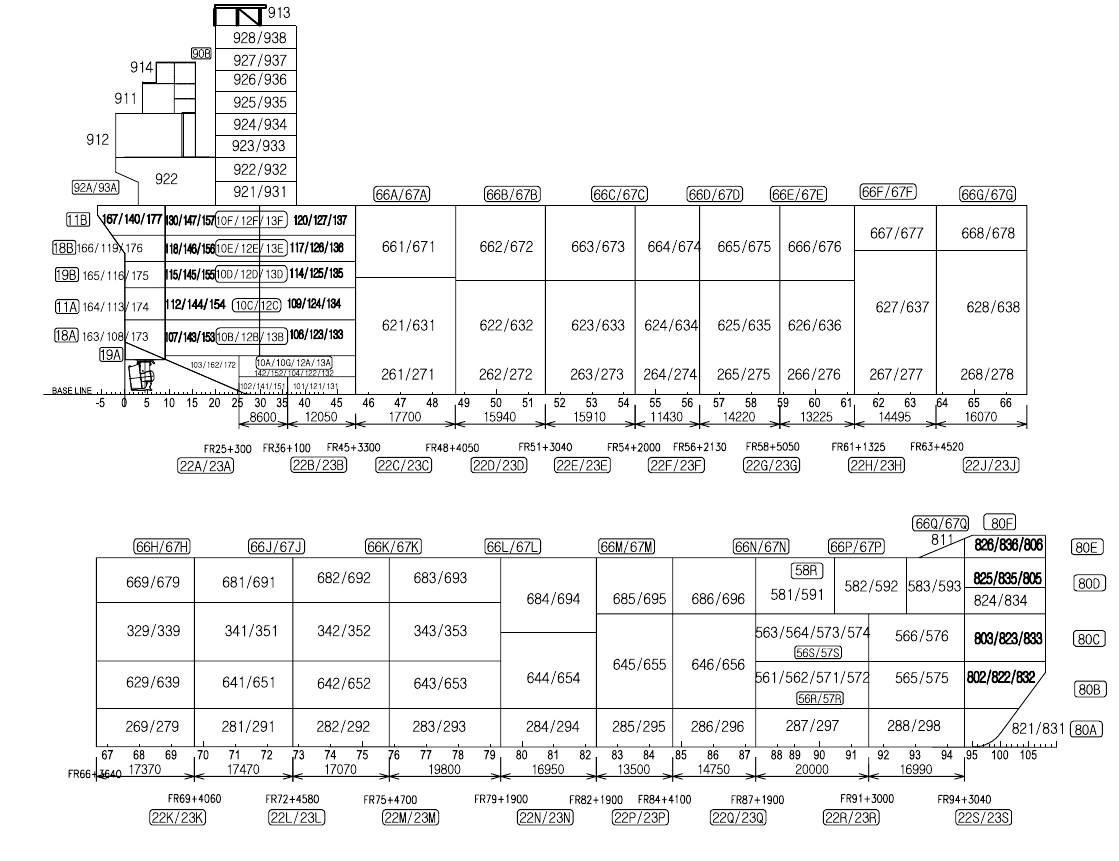
Fig. 4 Block division